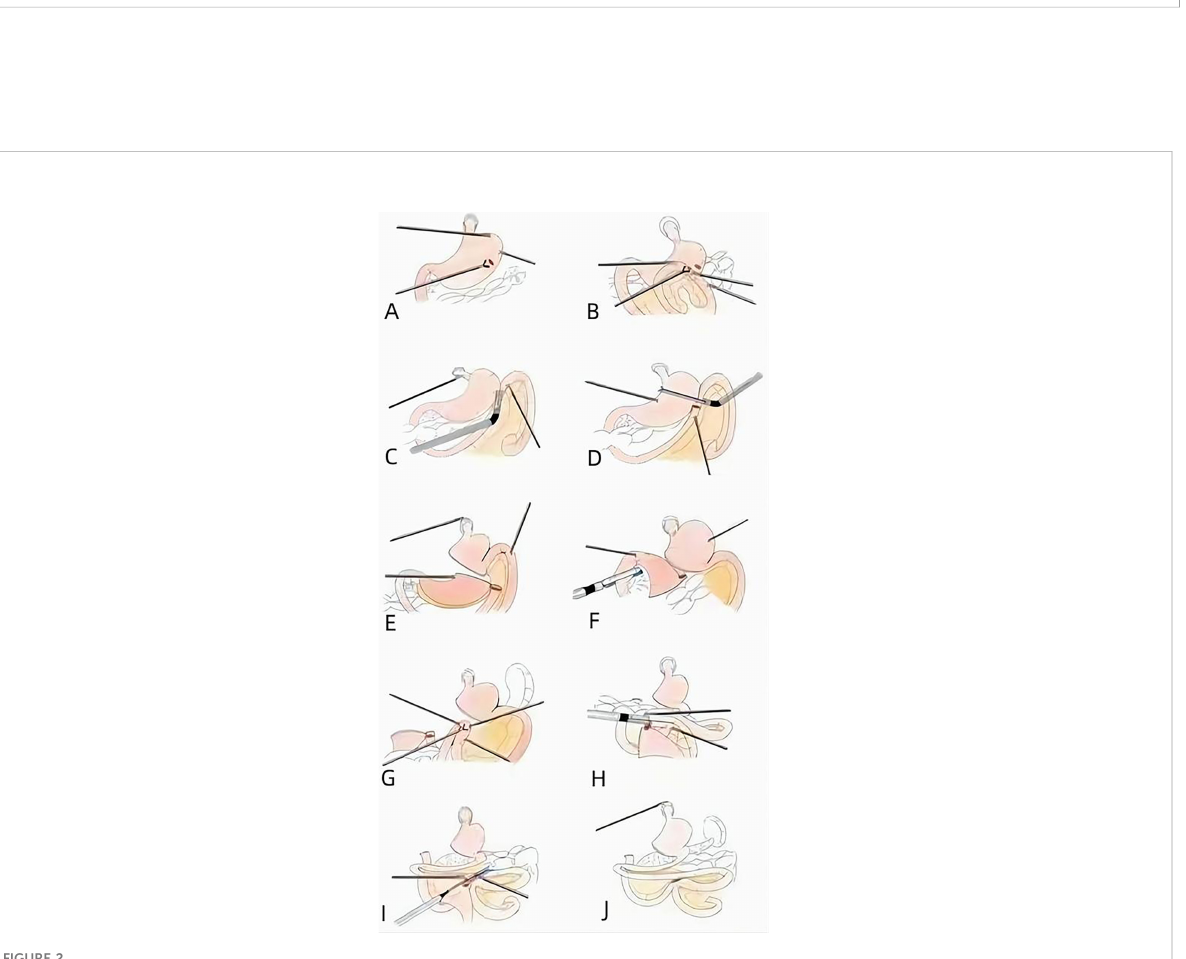
FIGURE 2 Procedure of SPLT-RY in TLDG. (A) Puncturing the posterior wall of the proximal stomach. (B) Puncturing the antimesenteric border of the jejunum. (C) Anastomosis of the proximal stomach and distal jejunum. (D) Closing the common opening. (E) Cutting off the proximal stomach. (F) Disconnecting the distal stomach and duodenum. (G) Puncturing the antimesenteric border of the small intestine. (H) Anastomosis of the small intestine and proximal jejunum. (I) Closing the common opening. (J) Removing the distal stomach. SPLT-RY, self-pulling and latter transected Roux-en-Y; TLDG, total laparoscopic distal